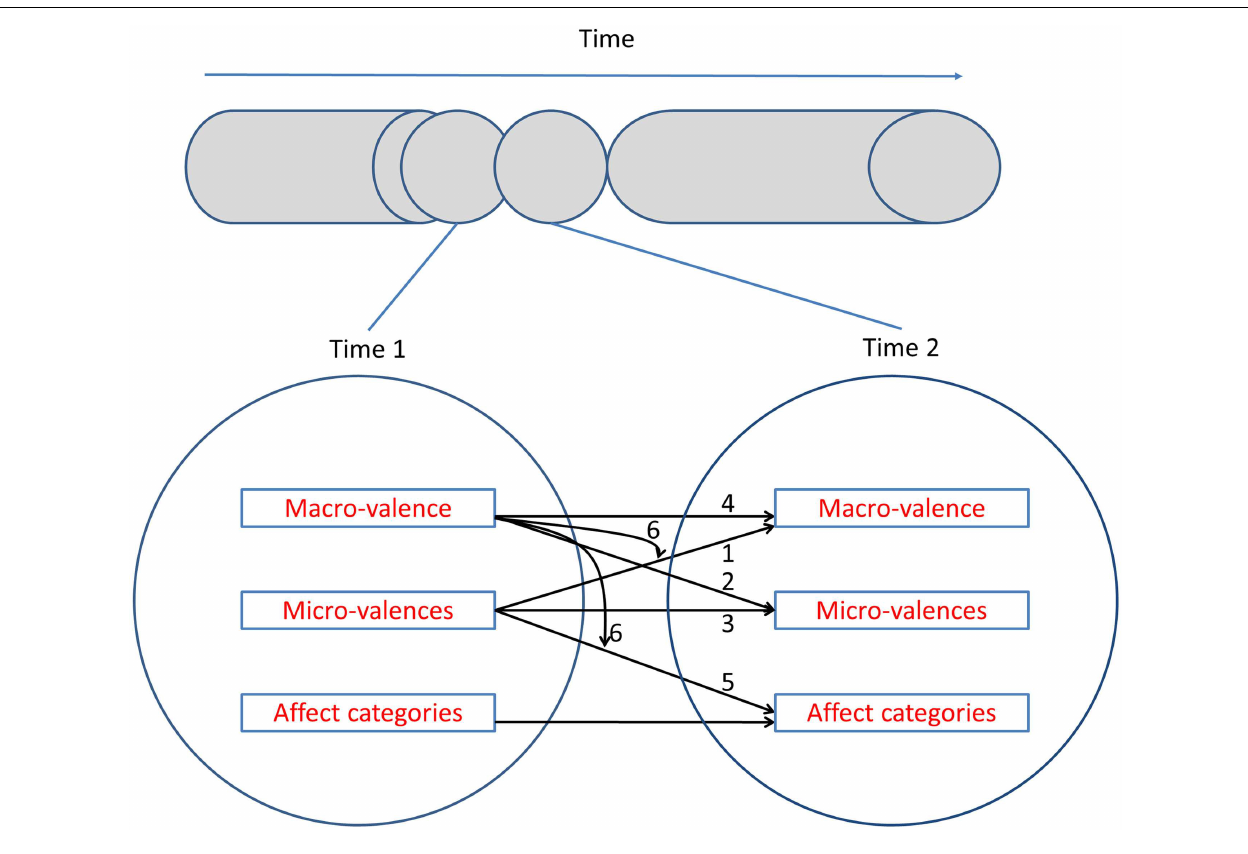
“From Micro-Valence atTime t to Micro-Valence atTime t + 1,” “From Macro-Valence atTime t to Macro-Valence atTime t + 1,” From Micro-Valence atTime t to Emotions atTime t + 1,” and “Macro-Valence atTime t Moderates the Paths from Micro-Valence atTime t to Emotions and Macro-Valence atTime t + 1” in the paper where the paths are